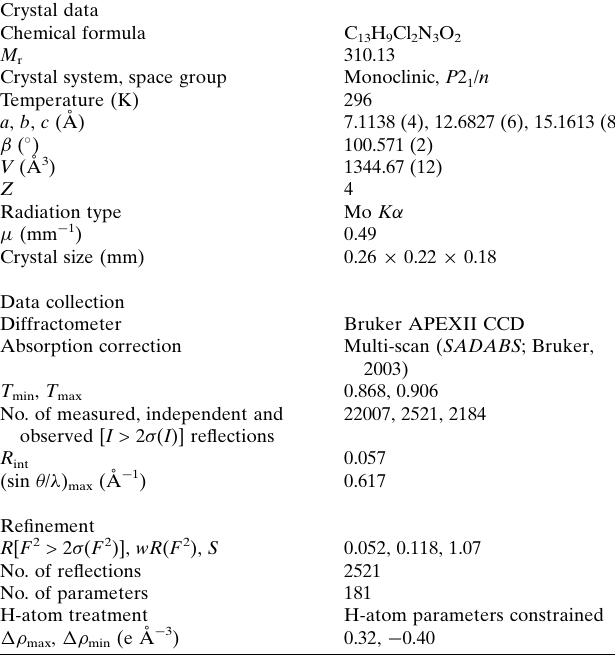
Table 4 Experimental details. Crystal data Chemical